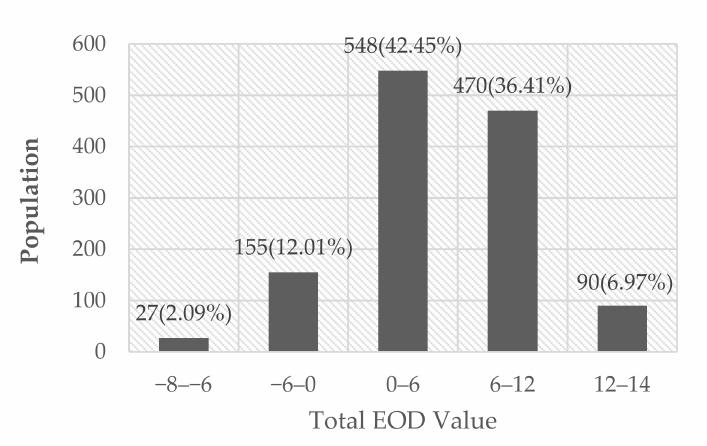
Figure 2. Distribution of total excess outpatient demand (EOD) value.